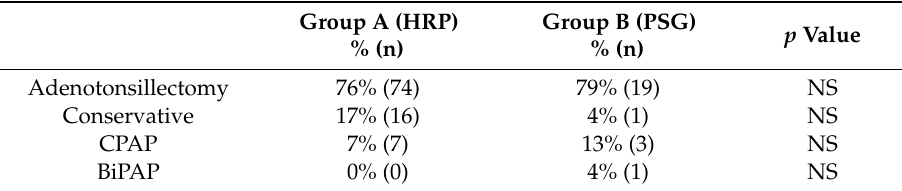
Table 6. Therapeutic approach by group.